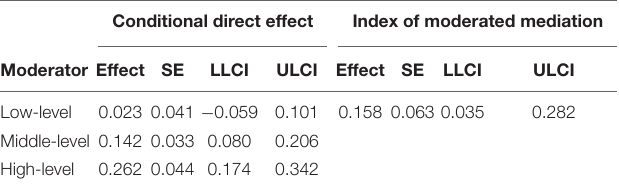
TABLE 6 | Bootstrap analysis of moderated